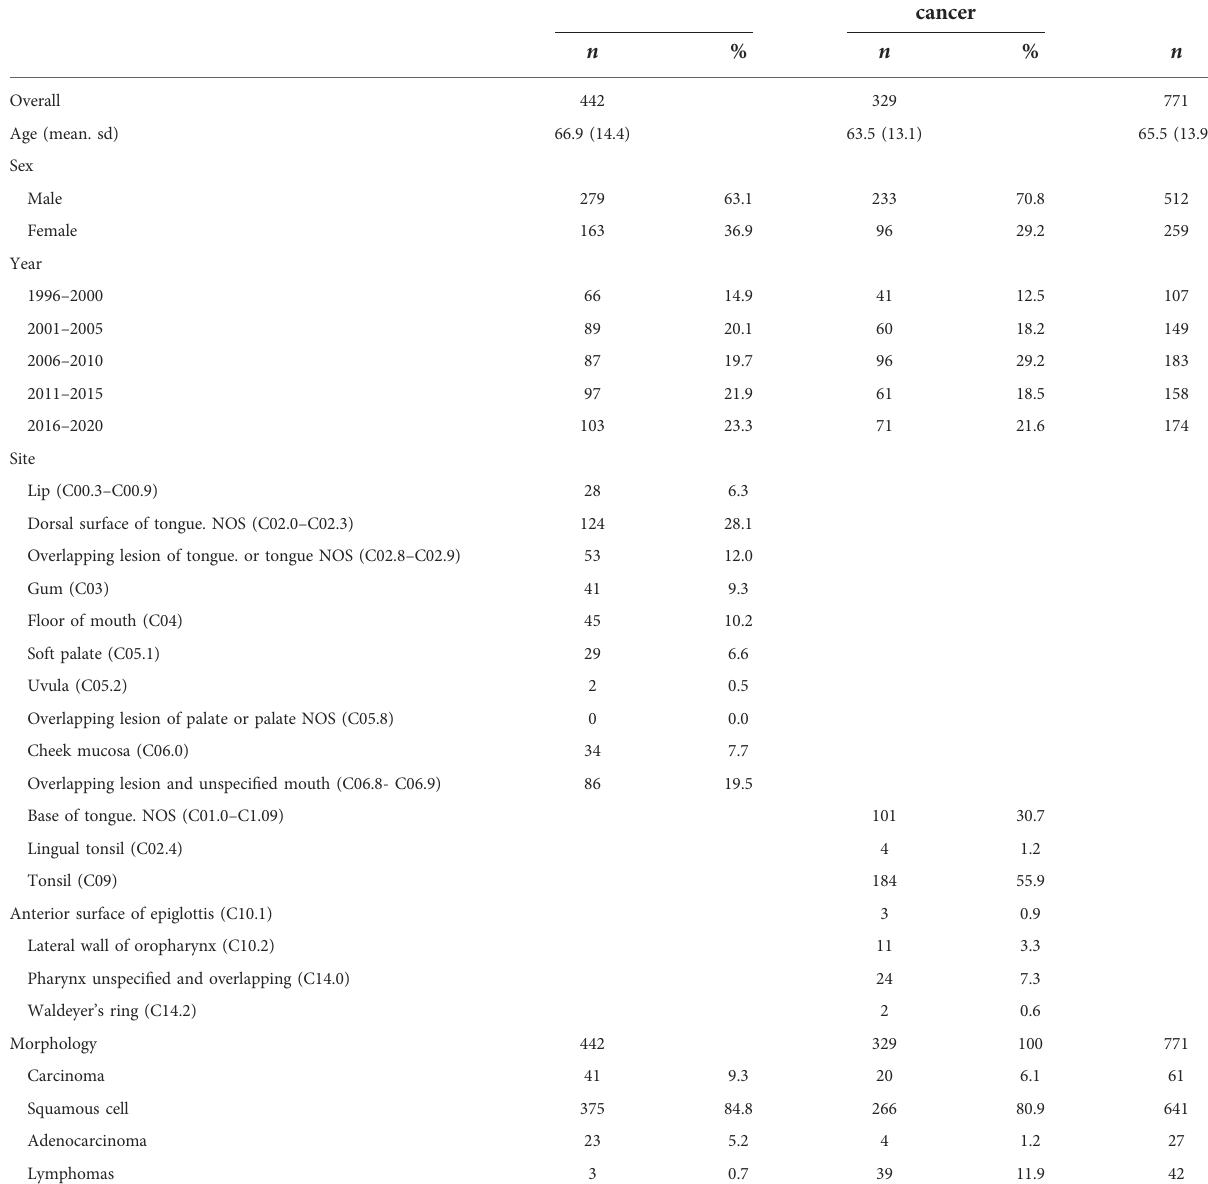
TABLE 1 Distribution of 771 patients with oral cancer, by age, sex, years of diagnosis, site and